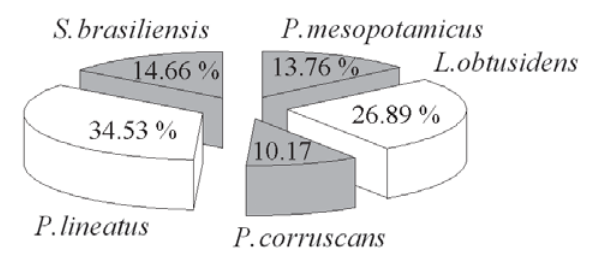
Fig. 4. Percent composition for important migratory fish spe- cies sampled in the Yacyreta elevators including dorado ( Salminus brasiliensis ), sábalo ( Prochilodus lineatus ), pacu ( Piaractus mesopotamicus ), boga ( Leporinus obtusidens ), and surubi ( Pseudoplatystoma corruscans and P. fasciatum ).